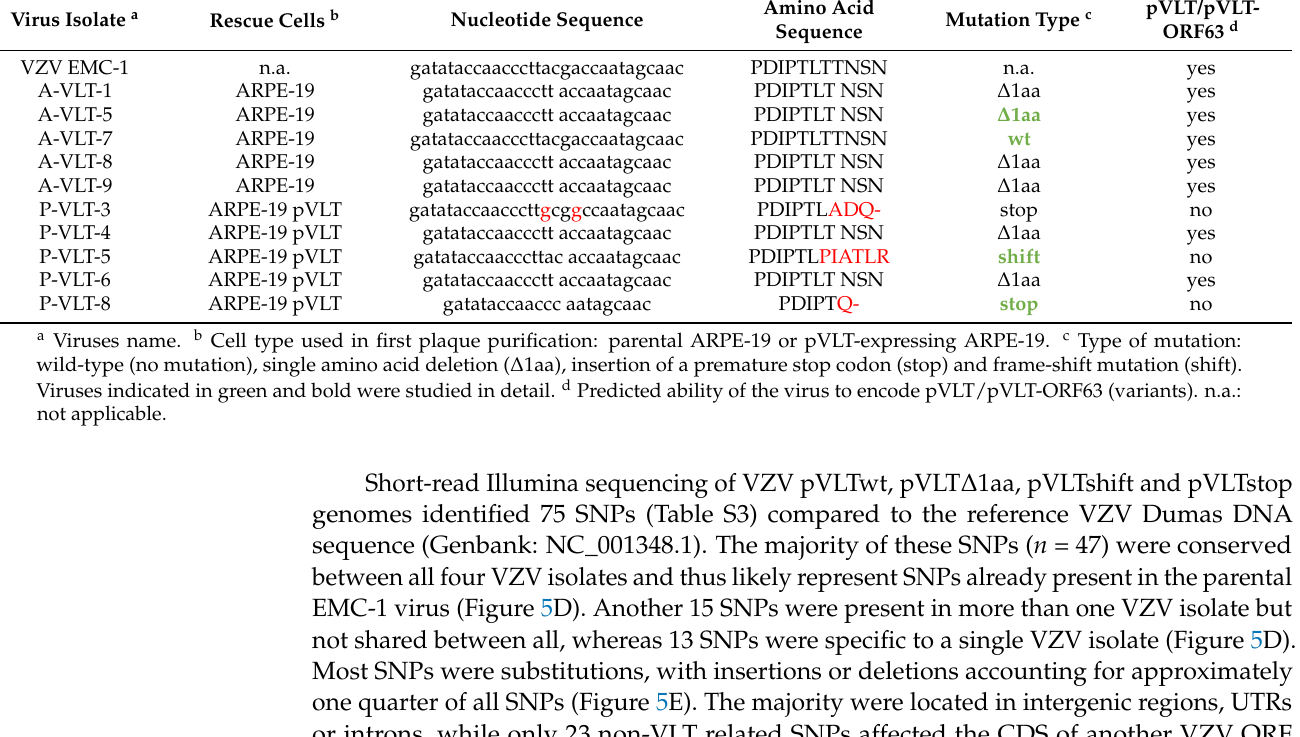
Table 1. Overview of viruses recovered from sgRNA VLT-9 expressing cells after plaque purification. Virus Isolate